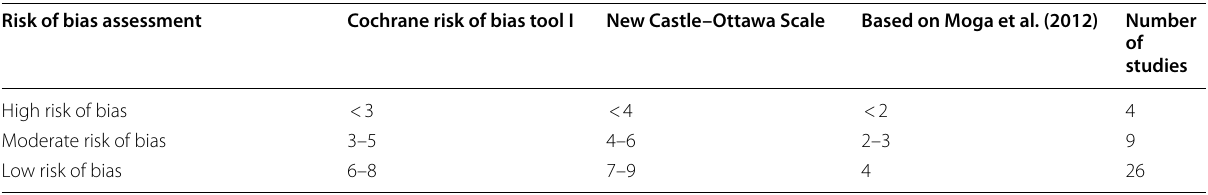
Table 2 Risk of bias assessment for clinical studies Risk of bias